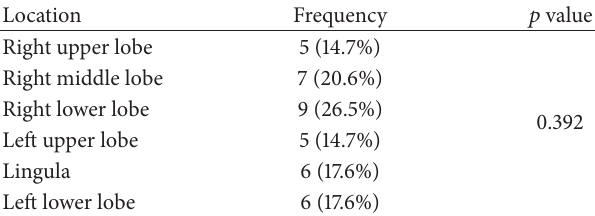
Table 4: Frequency of locations of nodules over one centimeter.